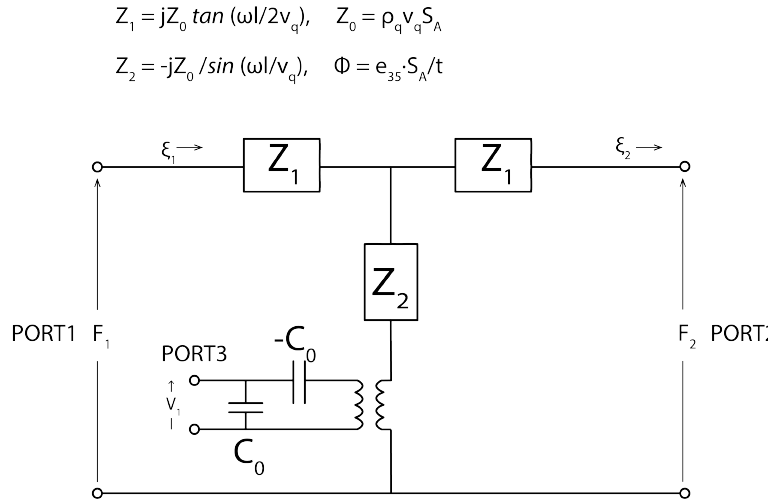
Figure 5. Coordinate system and notation used in this analysis.